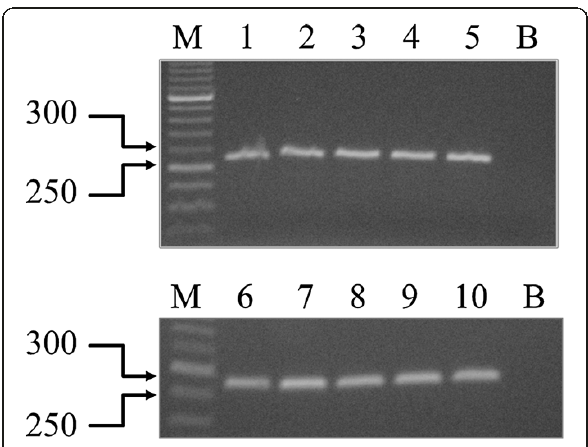
Figure 2 RT-PCR analysis of TCTP mRNA levels in the 10 samples. One microgram of total RNA was reverse transcribed and amplified in the presence of TCTP primers. Thirty cycles were run for both PCRs. The size of the MW markers is indicated. B, blank.